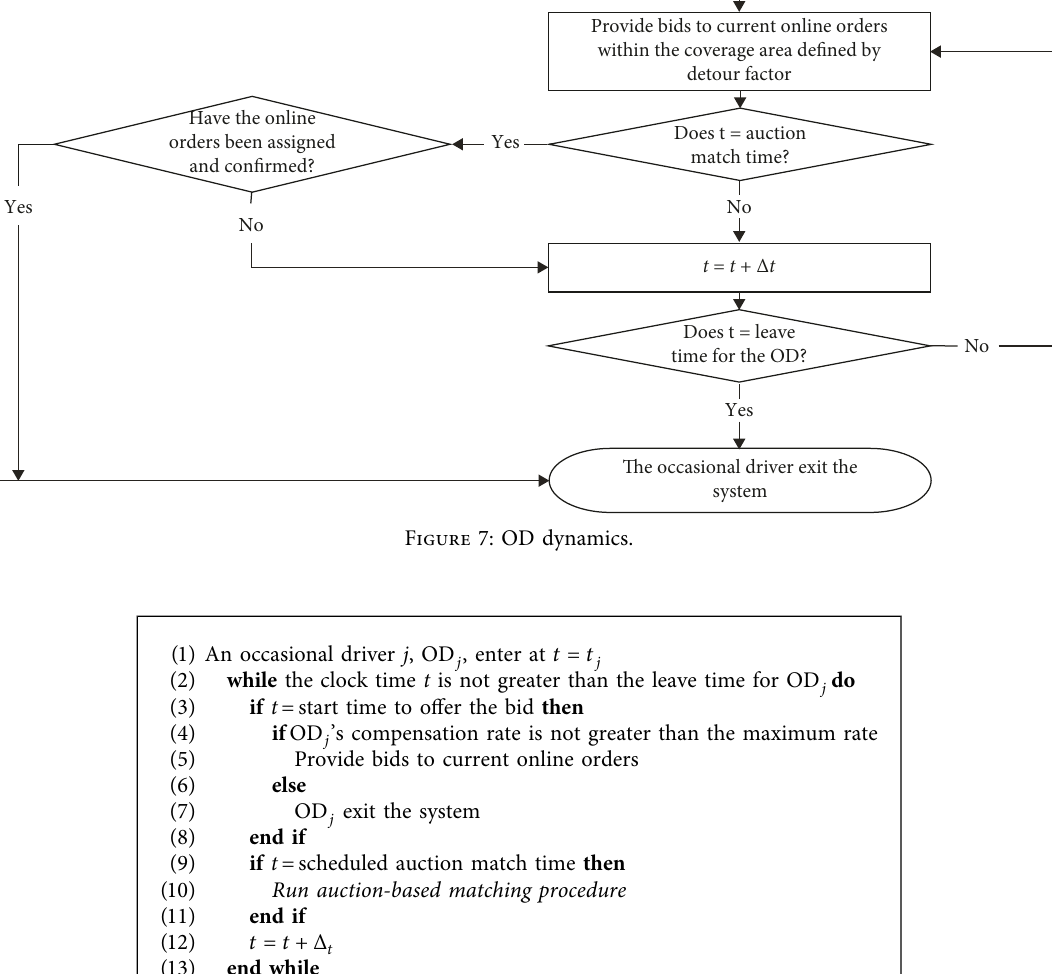
(5) Average order fulfillment time ( T f ) : The average time between the announcement of the online order and actual received time.